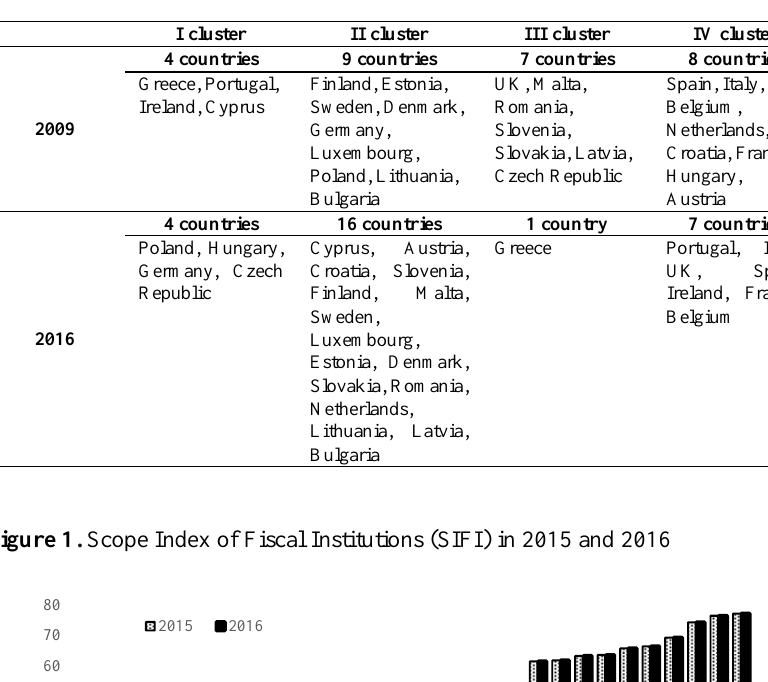
Table 1. Clusters in 2009 and clusters in 2016